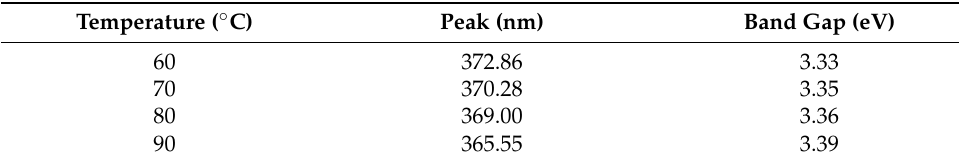
Table 2. The peak of the spectrum at different